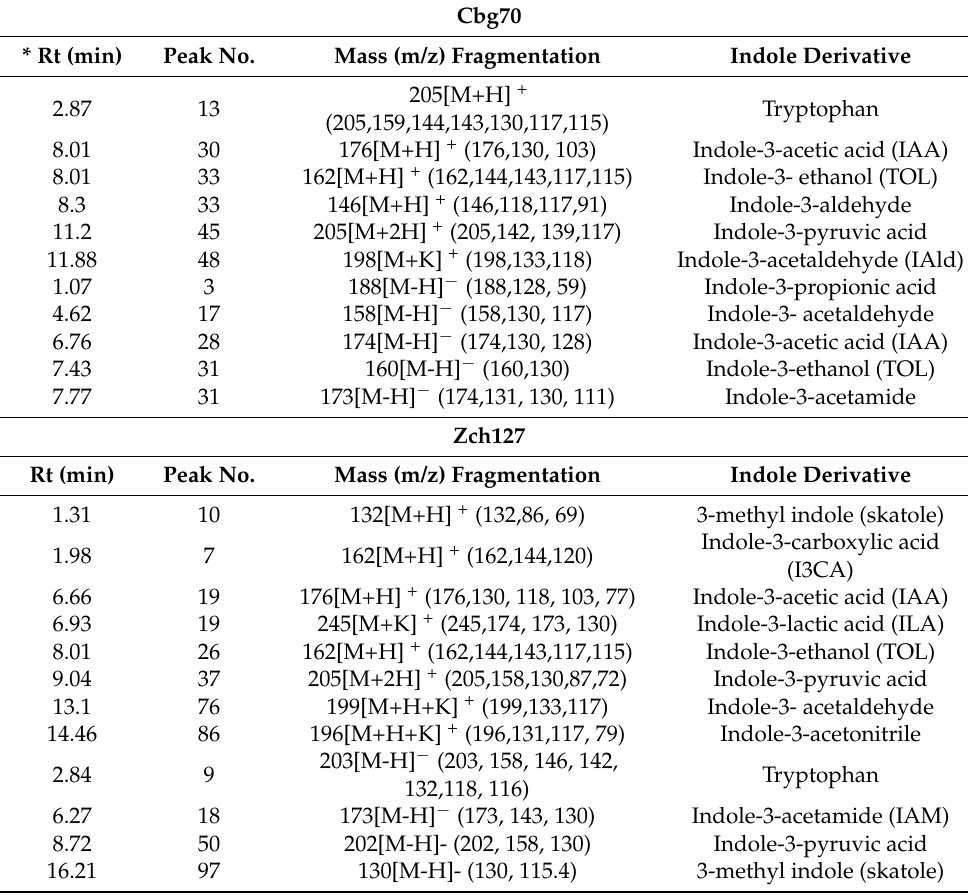
Table 2. LC-MS identified peaks of the extract from isolates Cbg70 and Zch127and their fragmentation